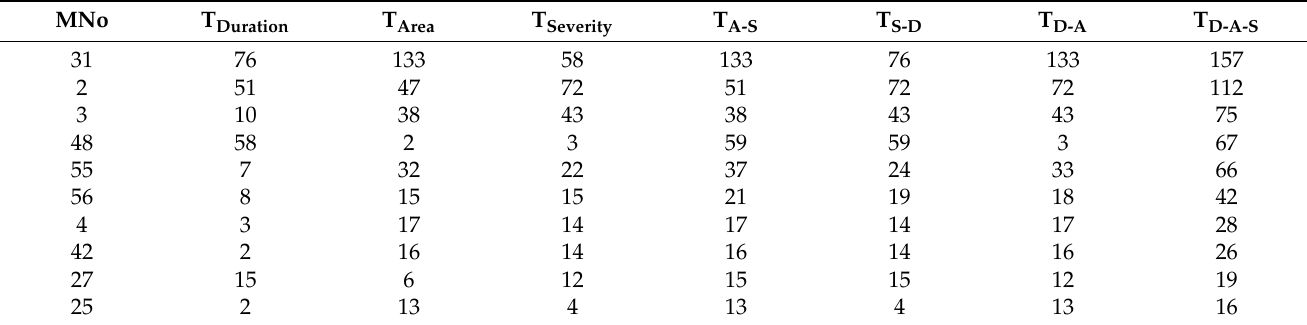
Table 3. The return period of the ten strongest historical meteorological droughts (unit: year).